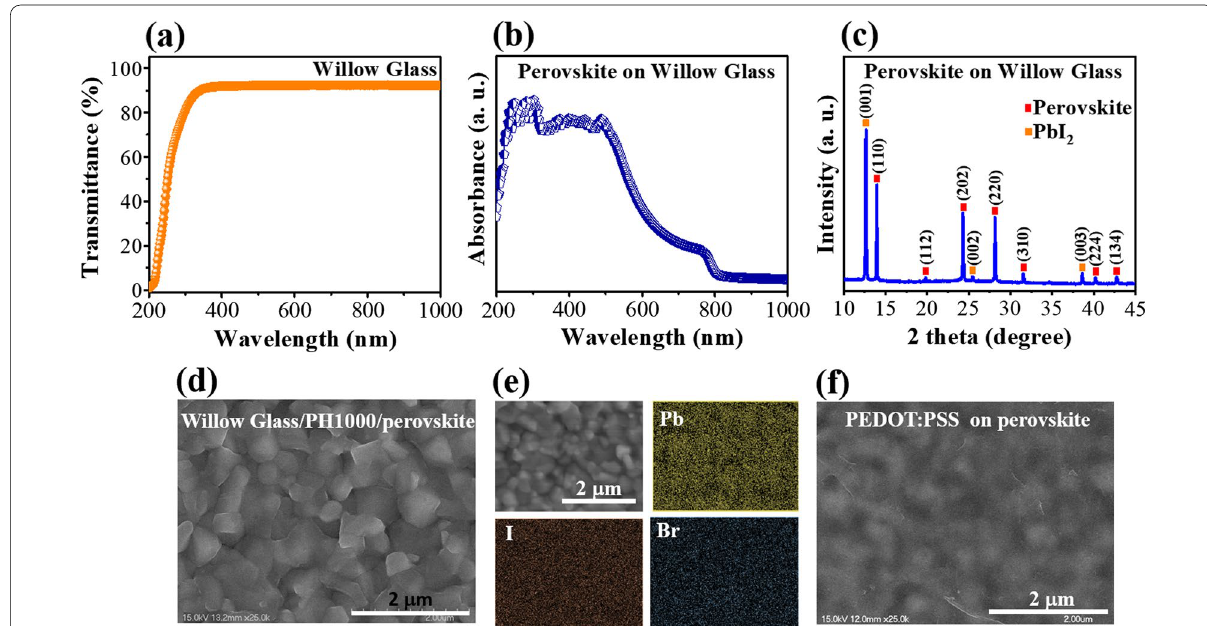
Fig. 1 a Transmission spectrum of flexible Willow Glass substrate; b Absorbance spectrum and c XRD pattern of the halide perovskite layer on Willow Glass substrate; d SEM image and e Elemental mapping of the perovskite layer; and f SEM image of the PEDOT:PSS top electrode